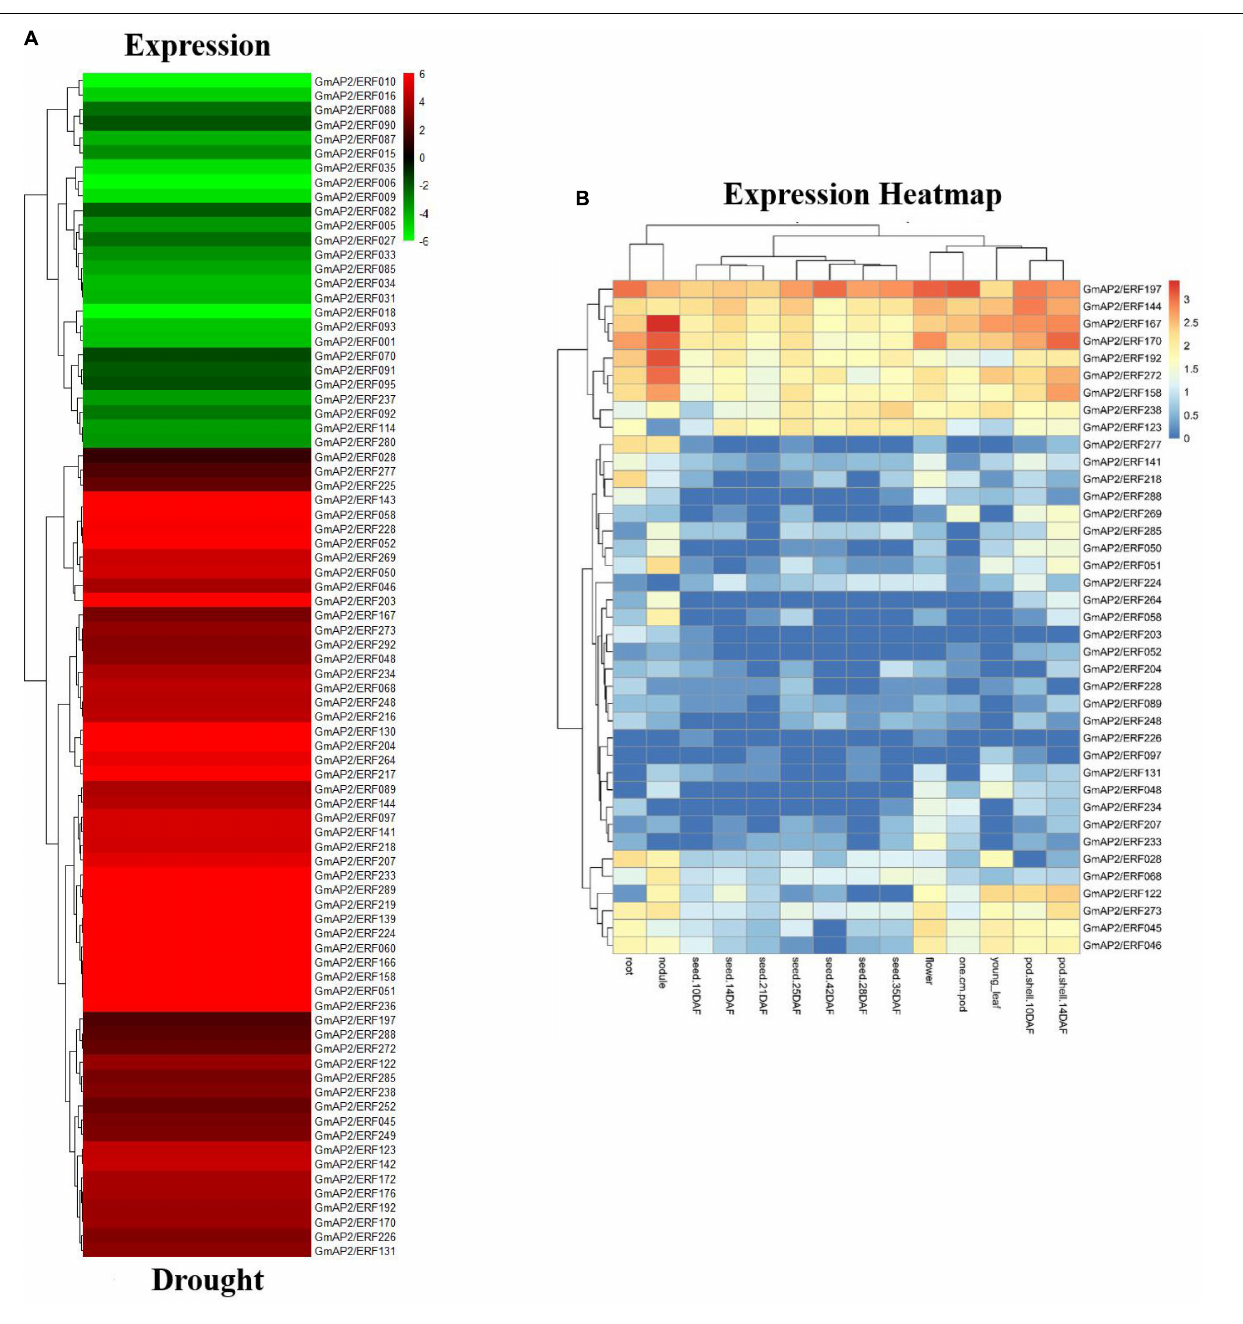
FIGURE 3 | Expression of drought-responsive differentially expressed genes and expression profiles of GmAP2/ERF genes in different soybean tissues. (A) Heat map with hierarchical cluster analysis of drought-responsive differentially expressed soybean GmAP2/ERF genes. Red indicates high relative transcript abundance, whereas green indicates low relative transcript abundance. (B) Heat map of expression profiles of soybean GmAP2/ERF genes in 14 soybean tissues. Hierarchical clustering of the 39 soybean GmAP2/ERF genes was constructed by average linkage with Euclidean distance in MeV 4.9 software. Different colors indicate relative transcript abundance of soybean GmAP2/ERF genes in 14 soybean tissues, with red indicating high abundance and blue indicating low